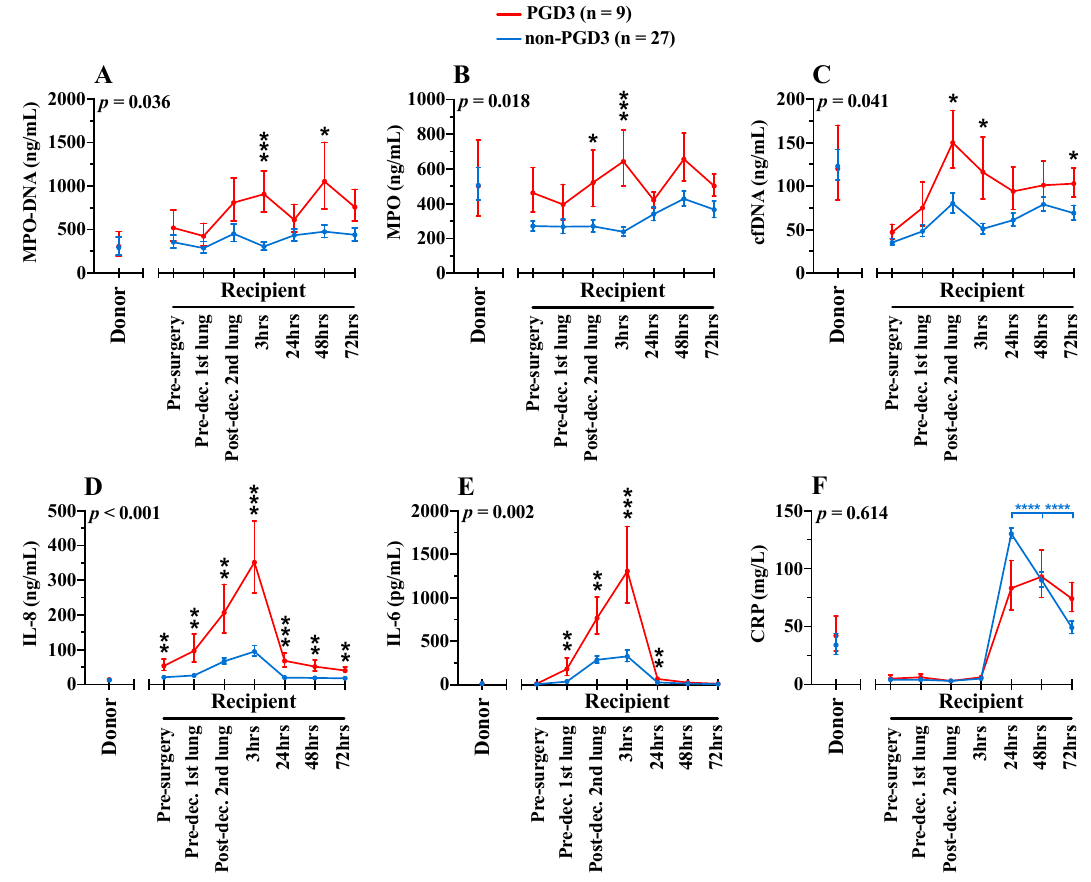
Figure 2. Pre-, intra- and postoperative serum levels of NETosis ( A – C ) and inflammatory ( D – F ) biomarkers in donors (n = 25) and recipients (n = 36). Blue lines show biomarkers in non-PGD3 recipients (n = 27) and red lines in PGD3 recipients (n = 9) (Mixed-method analyses). The 95% confidence intervals are represented with bars. p values represent the global inter-group comparisons over time. Significant time-point differences are illustrated with asterisks (*). * p < 0.05, ** p < 0.01, *** p < 0.001 and **** p <